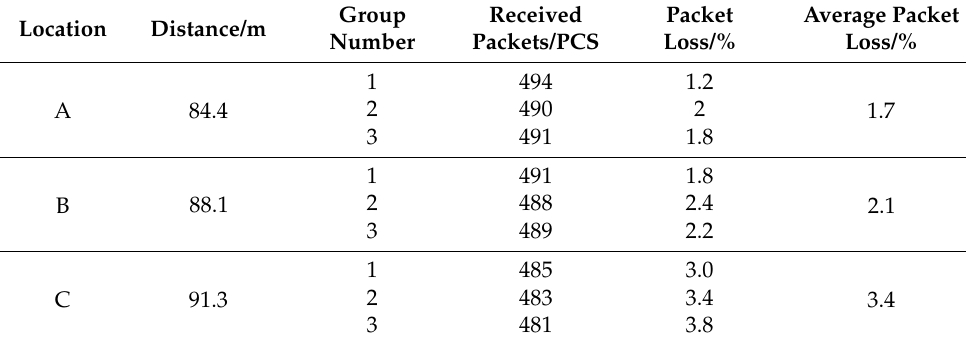
Table 1. Packet loss in robotic communication